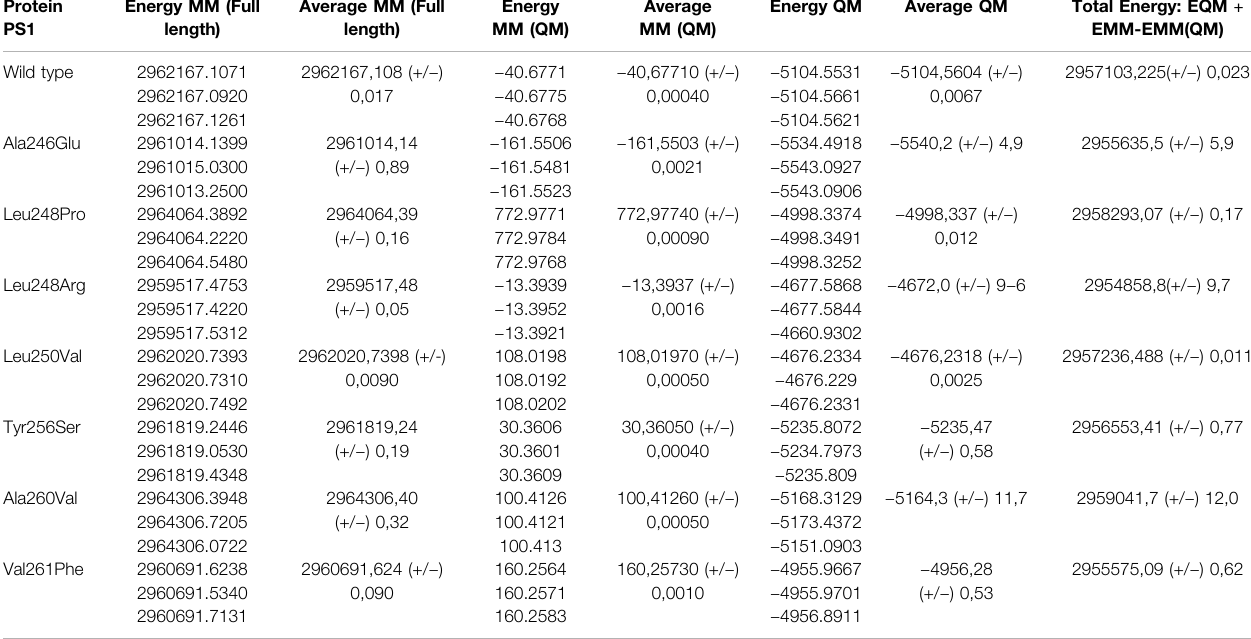
TABLE 2 | Energetic values calculated in the system with PS1 in the γ -secretase enzyme. Protein